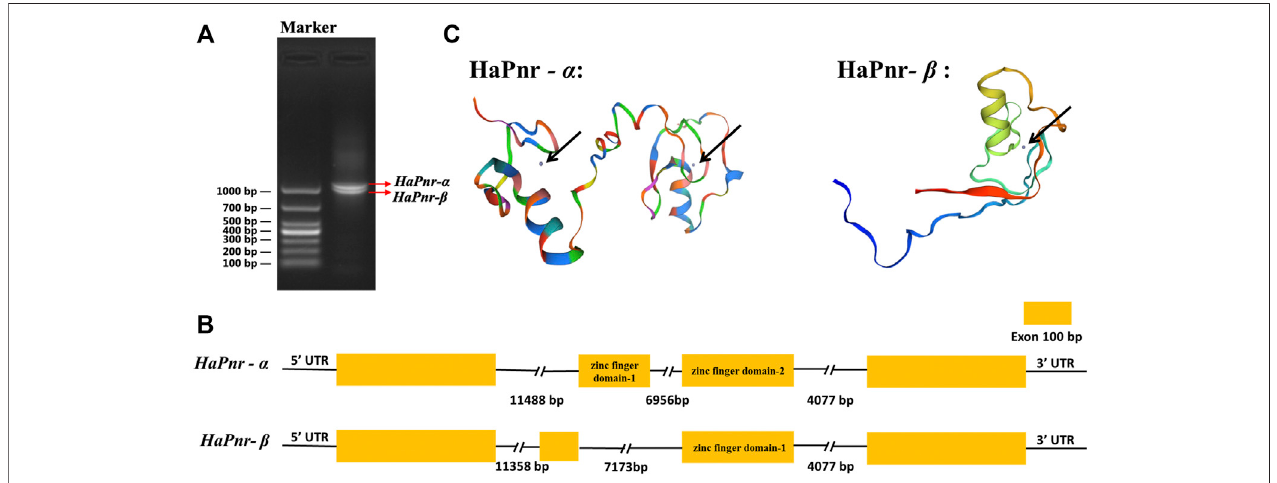
FIGURE1 | Electropherogram of HaPnr gene ampli fi ed, DL1000 (TakaraBio Inc., Japan) wasused as DNAmarker for agarose gel electrophoresis (A) . Schematic diagram for the organization of HaPnr- α and HaPnr- β (B) and the location of zinc- fi nger domain in the predicted protein structure chart of HaPnr- α and HaPnr- β (black arrow) (C)